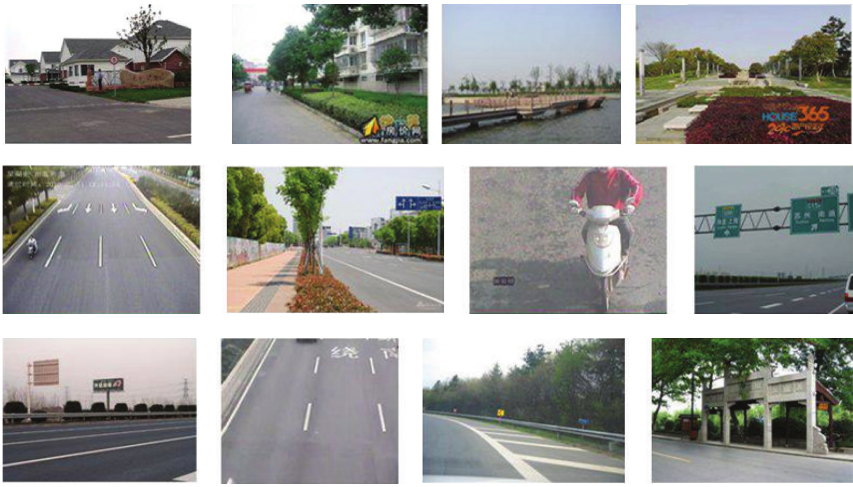
Figure 4: Examples of nonvehicle images as the negative samples.